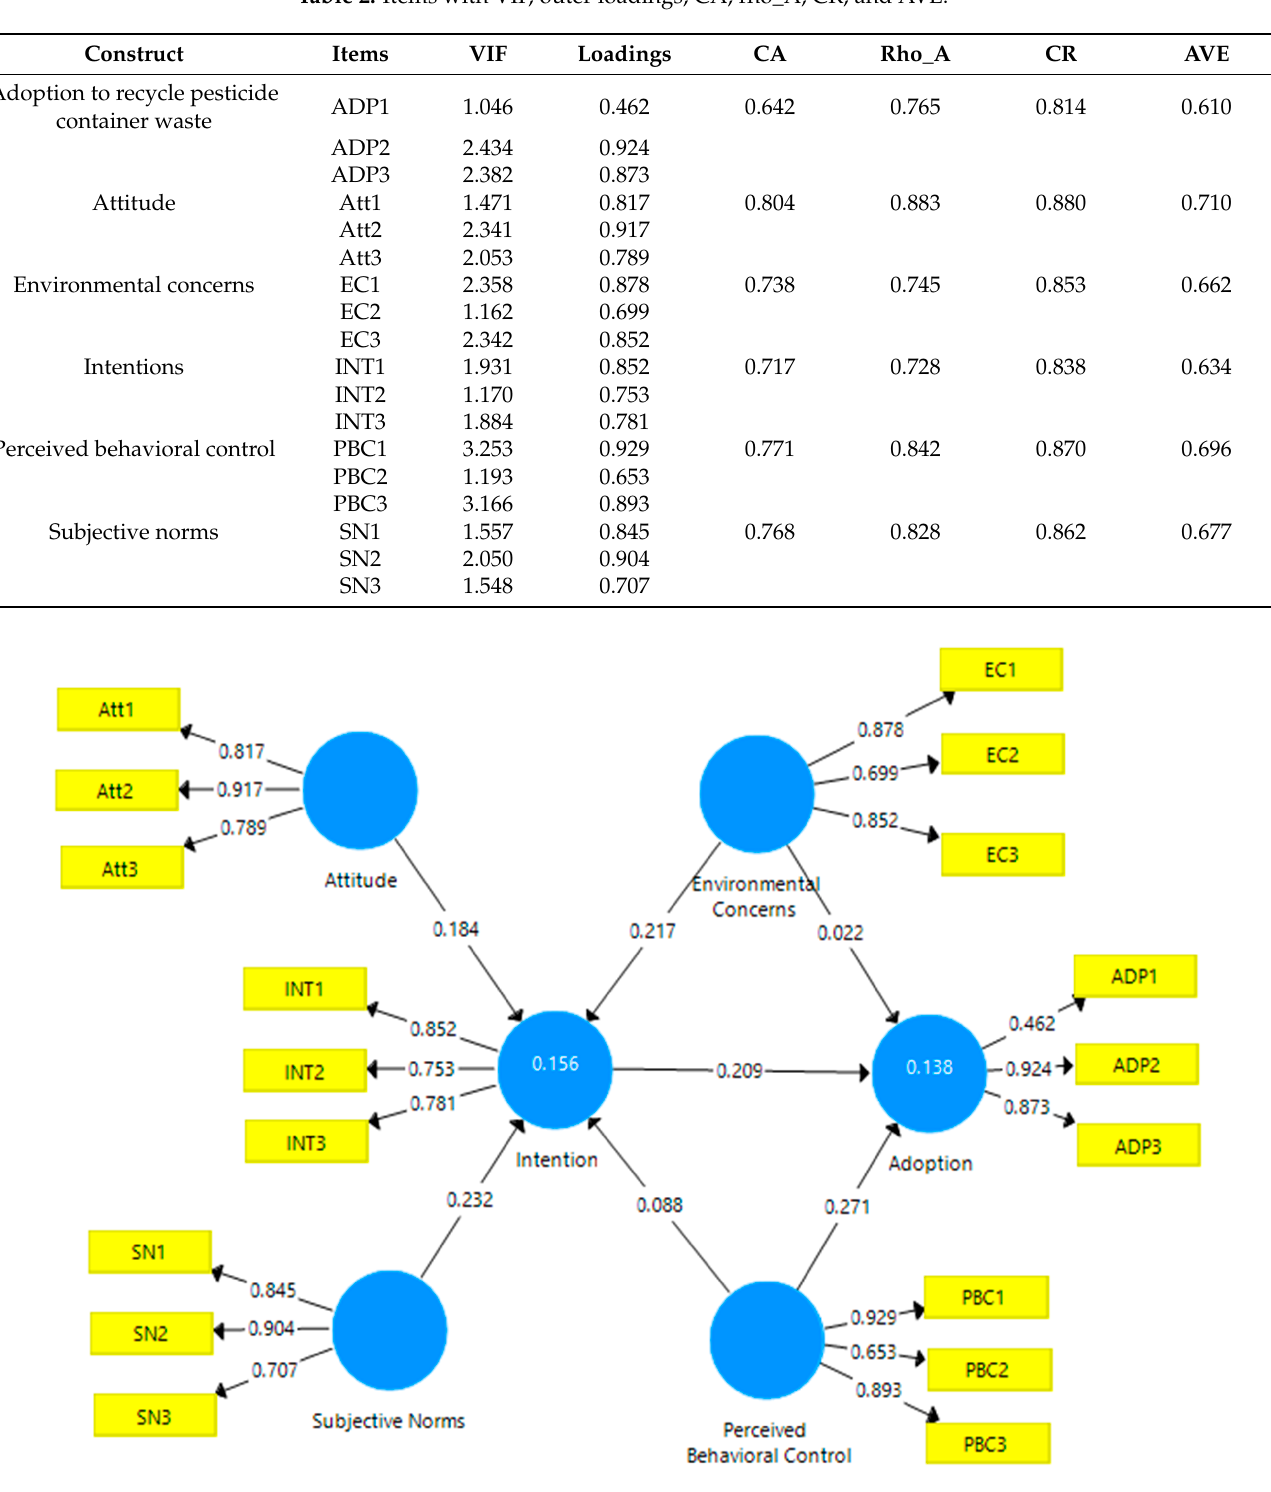
Table 2. Items with VIF, outer loadings, CA, rho_A, CR, and AVE.